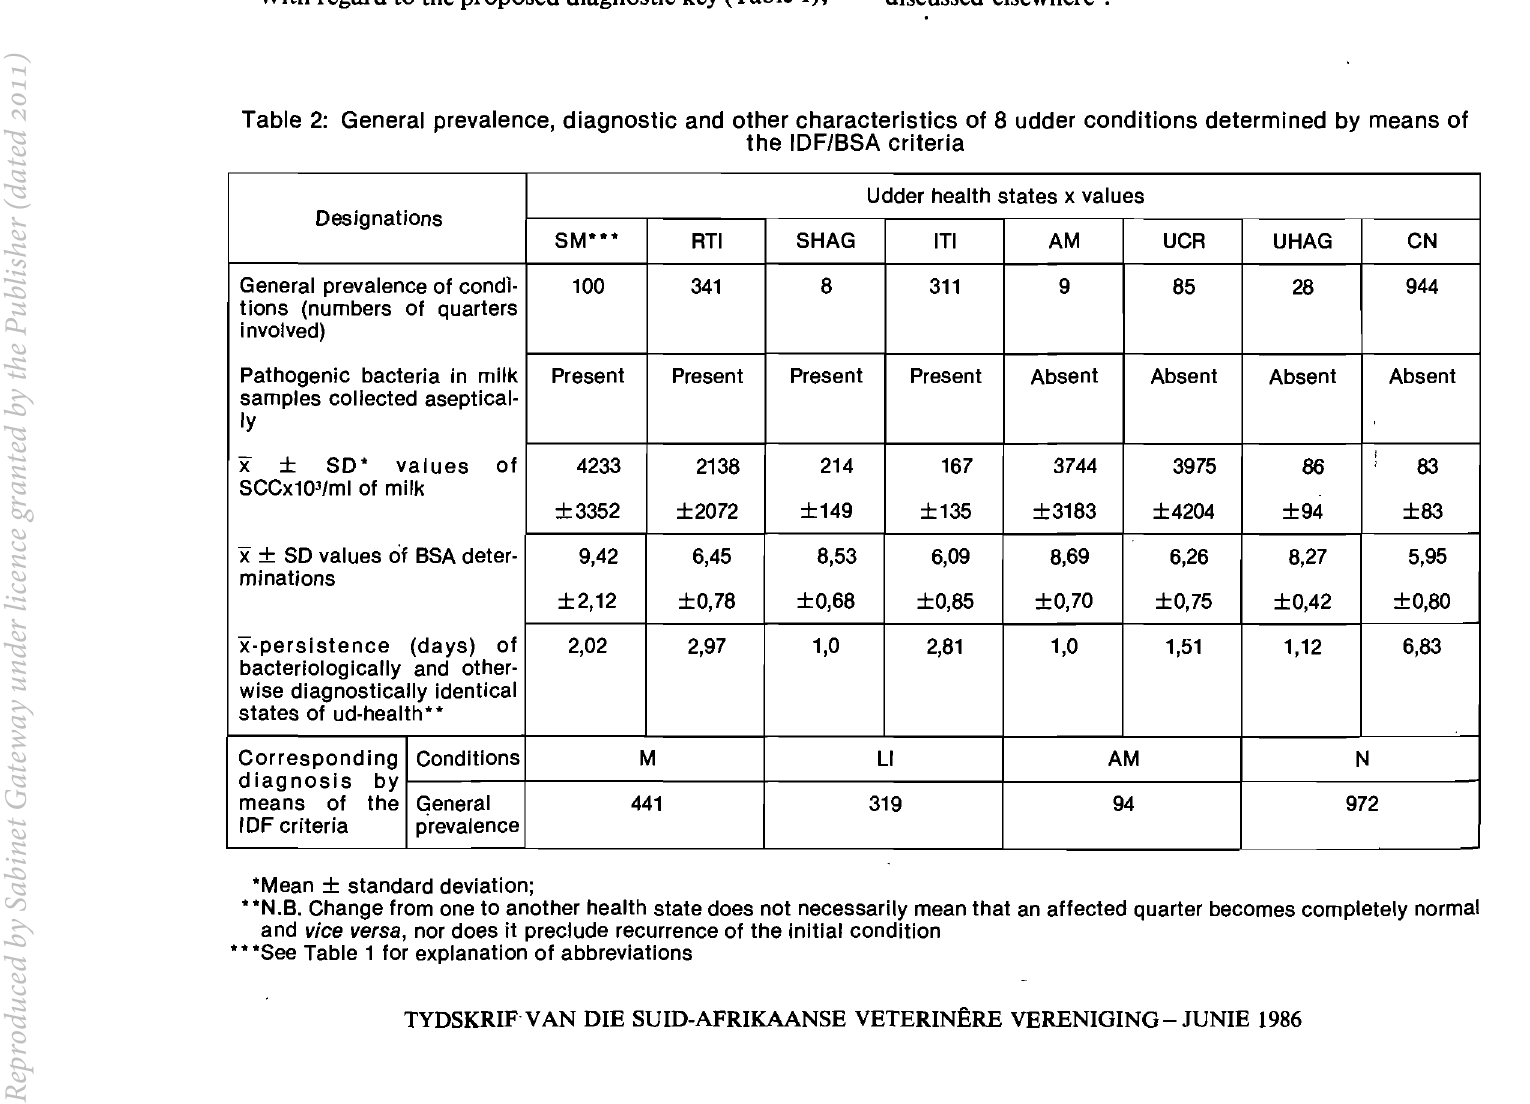
Table 2: General prevalence, diagnostic and other characteristics of 8 udder conditions determined by means of the IDF/BSA